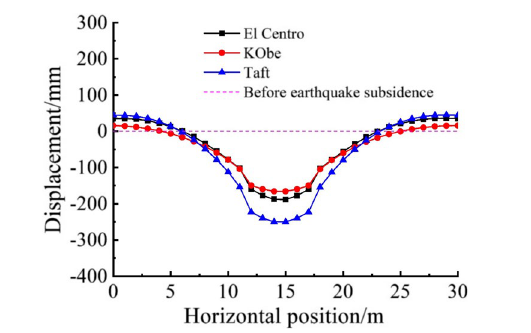
Fig. 21 Seismic subsidence due to different ground